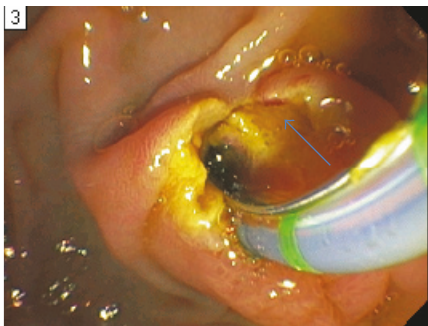
Figure 2: A duodenal varix (blue arrow) seen in the periampullary region on retroflexion during endoscopic retrograde cholangiopan- creatography (ERCP).